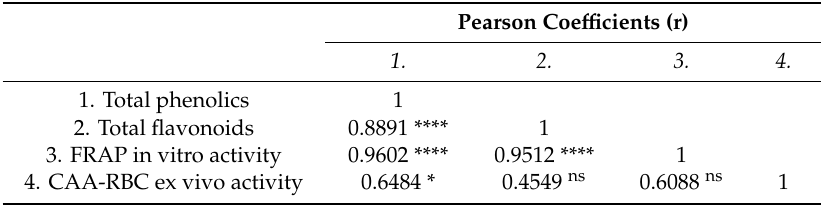
Table 4. Linear correlation coe ffi cients (r) between total phenolics, total flavonoids, ferric reducing antioxidant power (FRAP), and cellular antioxidant activity (CAA-RBC) data of analyzed bee pollens ( n = 10) considered as a unique sample. Pearson correlation, two-tailed: * p < 0.05; **** p < 0.0001. ns = not statistically